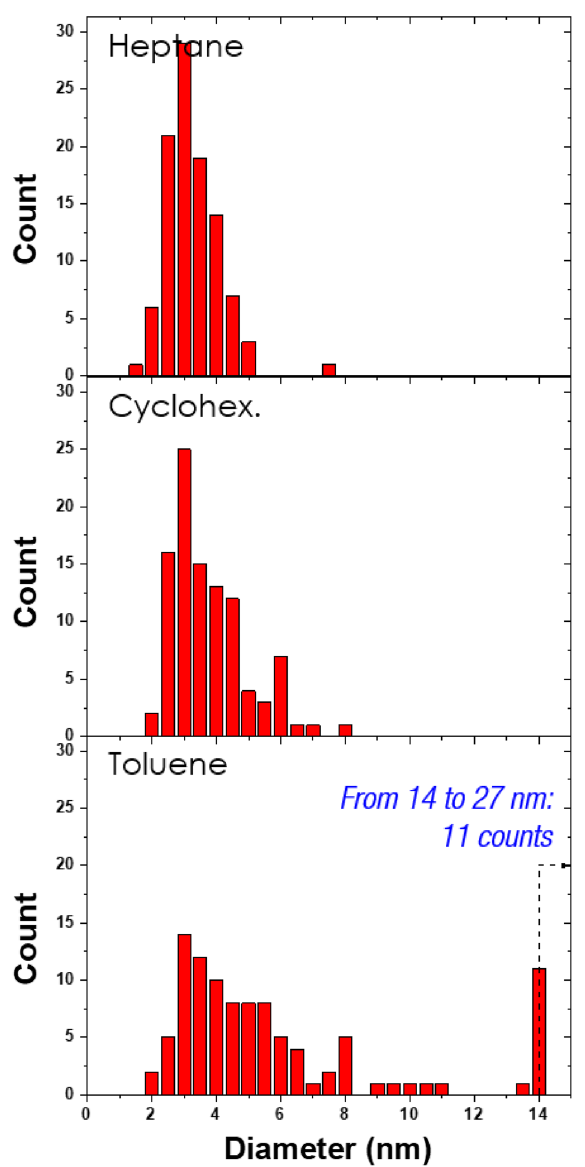
Figure 7. Distribution of the Cu NPs embedded in carbonaceous matrices (n = 100 particles for each